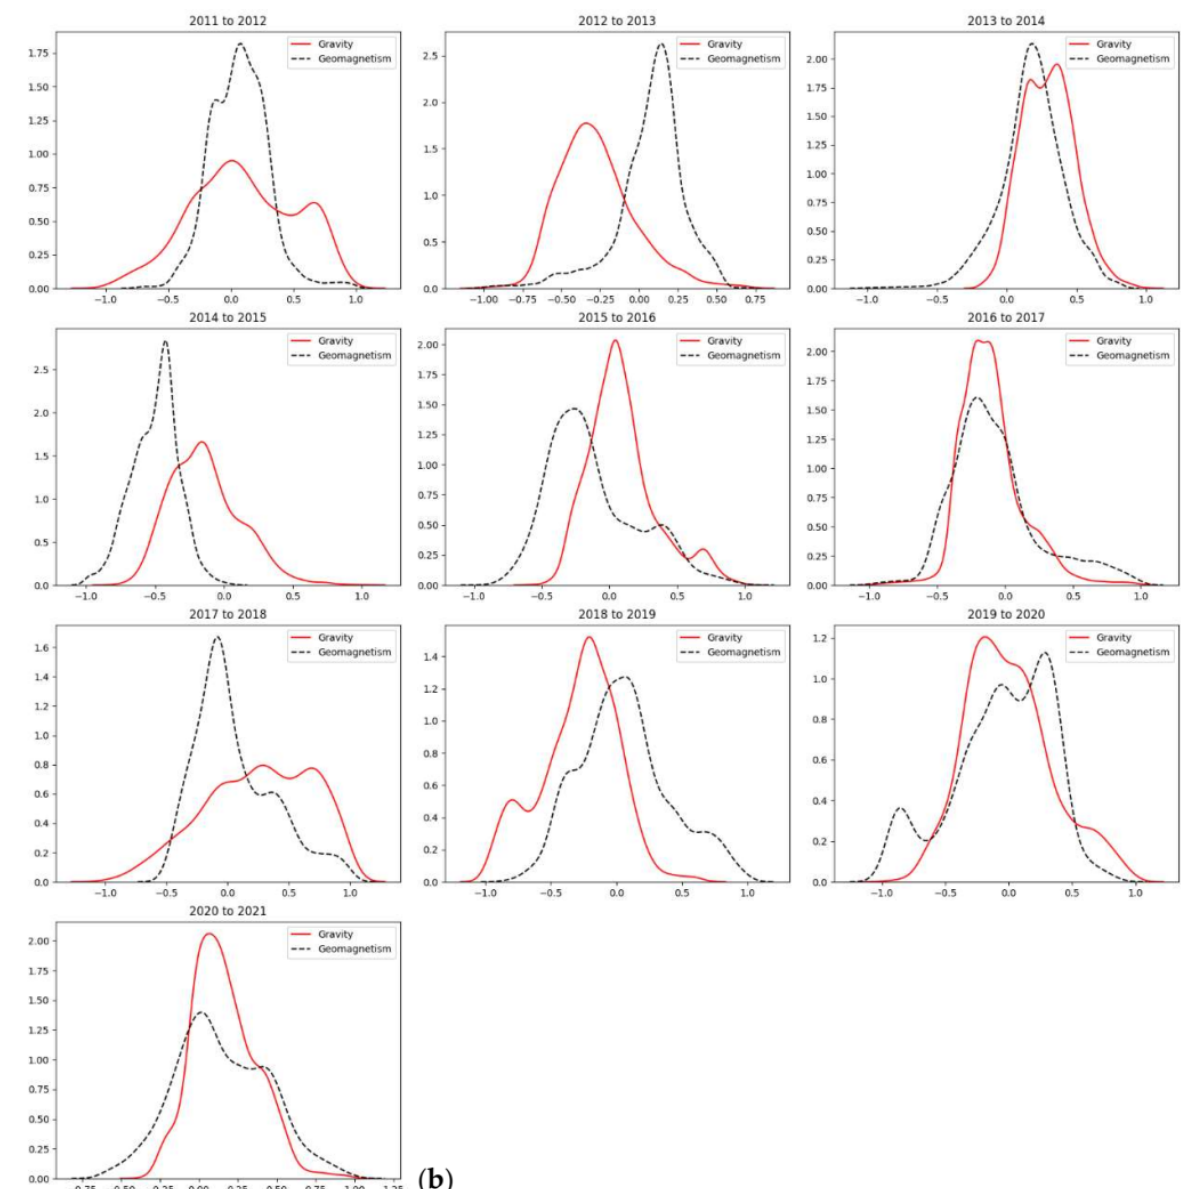
Figure 3. The histogram and nuclear density map of the uniform number of grid point changes in the gravity and magnetic field after normalization from 2011 to 2021. ( a ) Histogram of uniform number of grid points of gravity and magnetic field after normalization (the ordinate represents the quantity and the abscissa represents the normalized interval value); ( b ) The normalized gravity and magnetic field grid points change uniform number nuclear density map (the ordinate represents the kernel density value, and the abscissa represents the normalized interval range